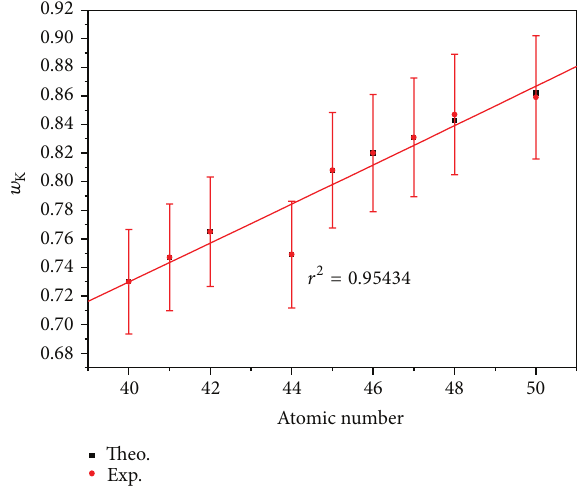
Figure 3: The variation in 𝜎 function of atomic number.